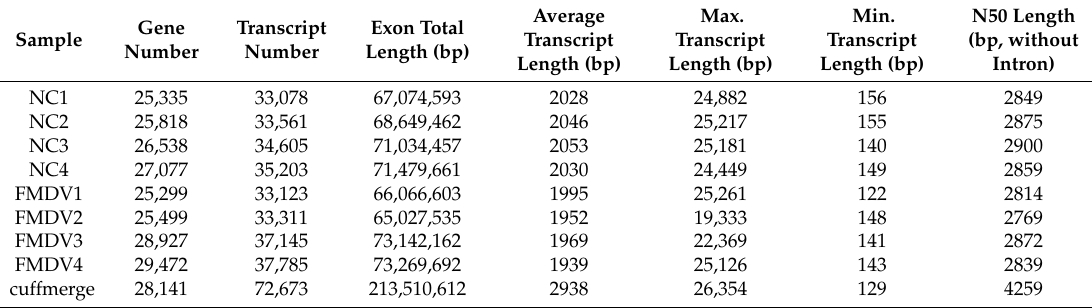
Table 3. Assembled